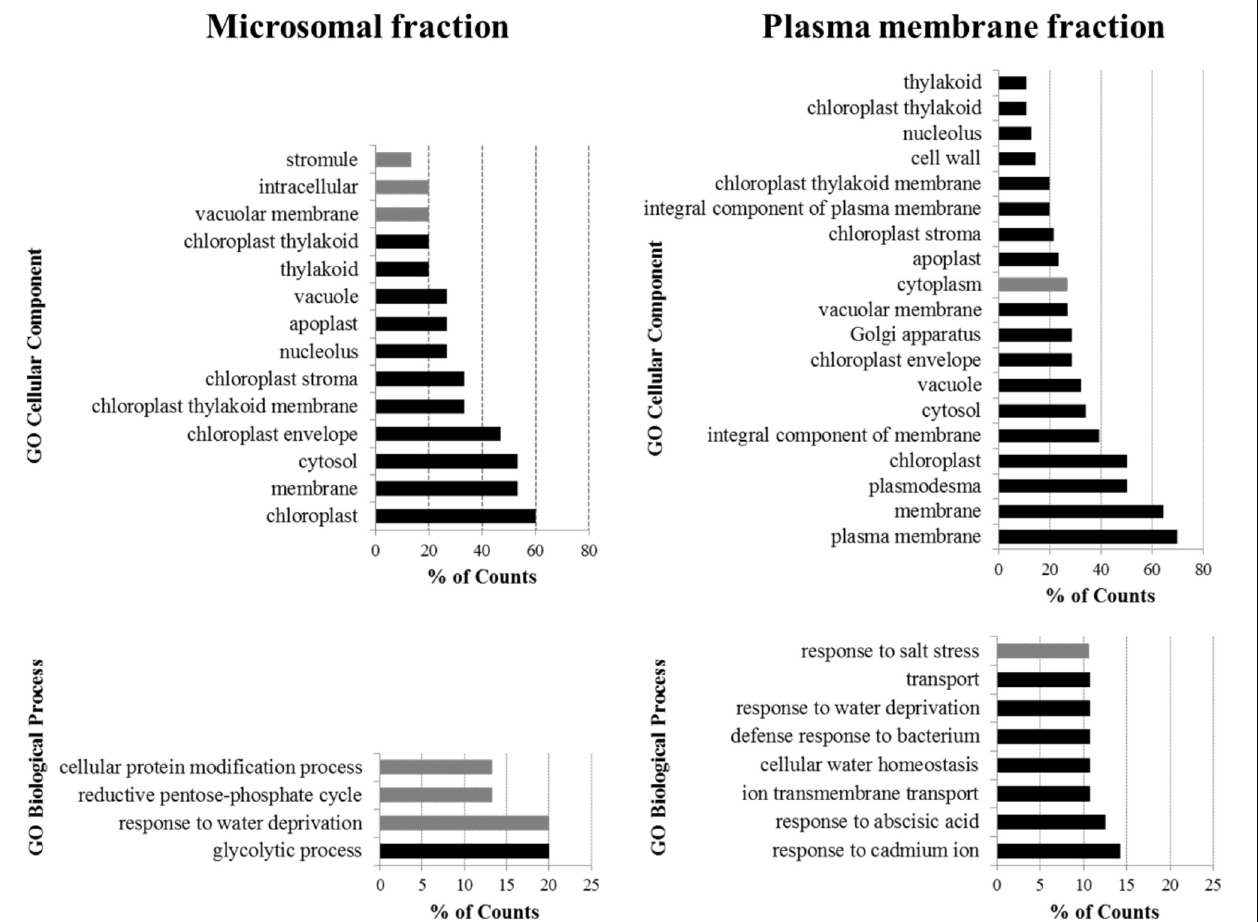
FIGURE 3 | Cluster analysis of GO annotation terms of proteins enriched by IP of microsomal and plasma membrane fraction. The DAVID Bioinformatics Resources functional annotation clustering algorithm was used to cluster the most significant terms in the GO Cellular Component and GO Biological Process annotations. The terms are ordered from least frequent (top) to most frequent (bottom). Black bars indicate terms enriched with p < 0.01, gray bars indicate terms enriched with p ≥